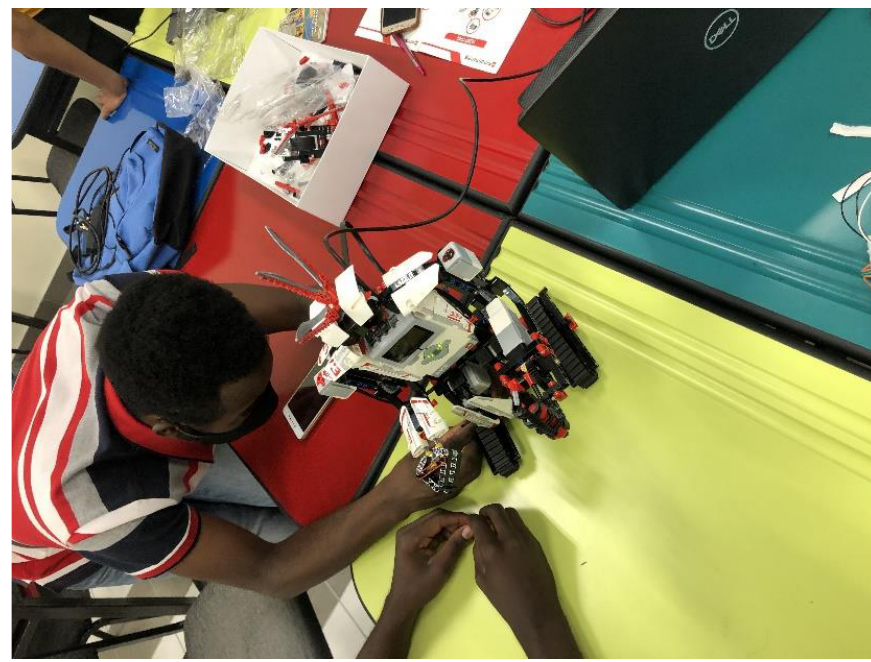
Figure 2. Arduino robotics prototype by engineering students at JEDS campus.